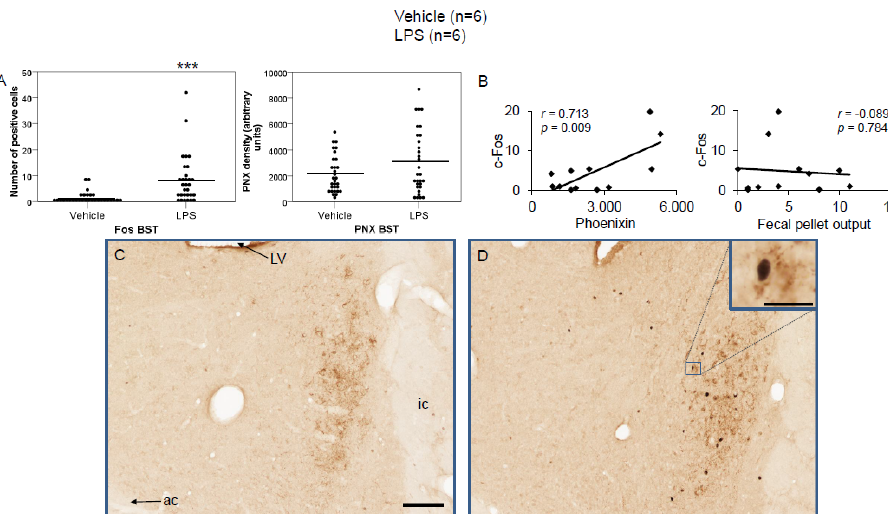
Figure 6. LPS stimulates c-Fos expression in the bed nucleus of the stria terminalis. Ad libitum-fed rats were subjected to IP injection of LPS or control, and 180 min after the injection, brains were processed for c-Fos and phoenixin double-immunohistochemistry. LPS stress significantly increased the number of c-Fos-positive cells but did not alter phoenixin density compared to controls ( A ). A significant correlation was observed between c-Fos and phoenixin immunoreactivity, but not between the number of c-Fos and fecal pellet output ( B ). Representative pictures of the evaluated slides are shown in ( C ) (control) and ( D ) (LPS). The scale bar represents 100 μ m in the overview and 20 μ m in the insert. Data are expressed as individual data points (5/animal) and mean in ( A ). Mean values per animal are plotted in ( B ). *** p < 0.001. Abbreviations: ac, anterior commissure; BSt, bed nucleus of the stria terminalis; ic, internal capsule; LV, lateral ventricle.